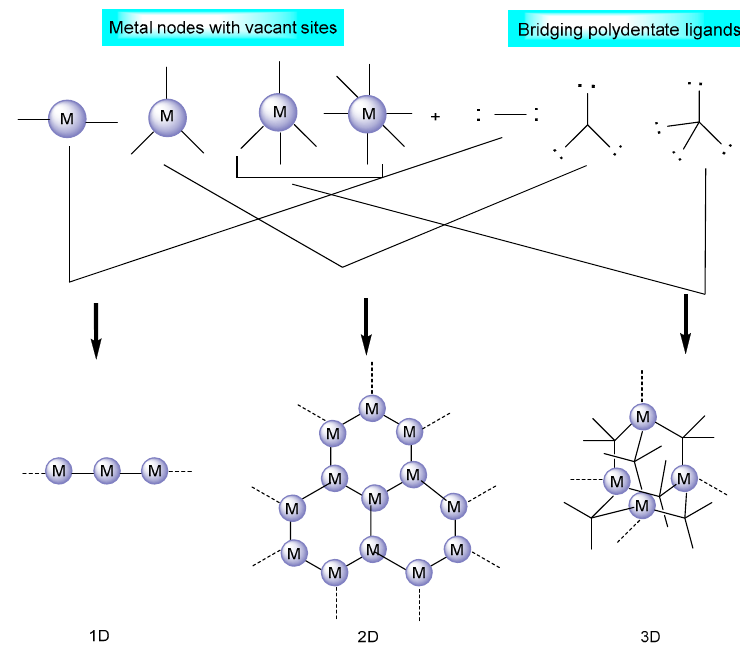
Figure 2. MOF structure based on the metal nodes and bridging ligands [31].